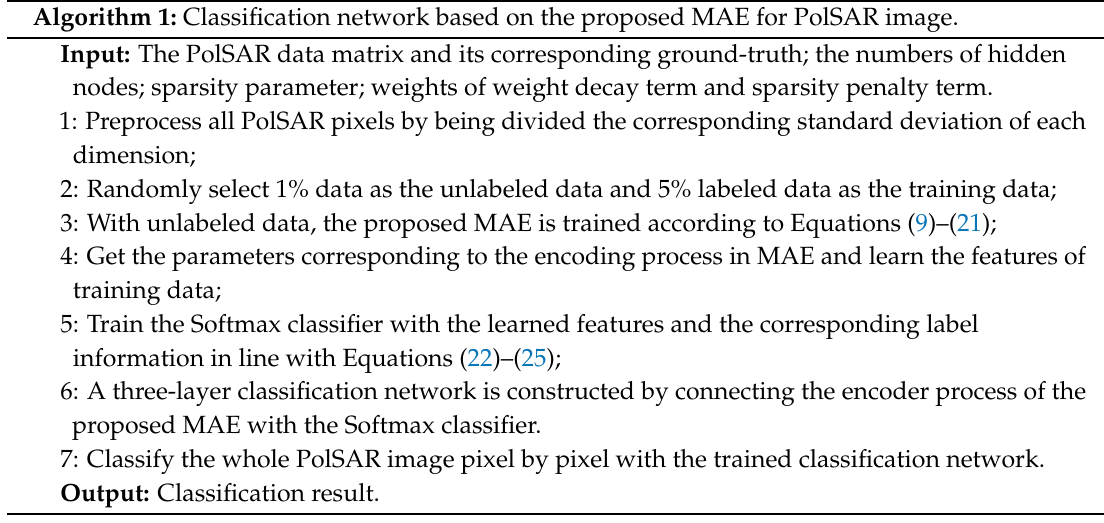
Algorithm 1: Classification network based on the proposed MAE for PolSAR